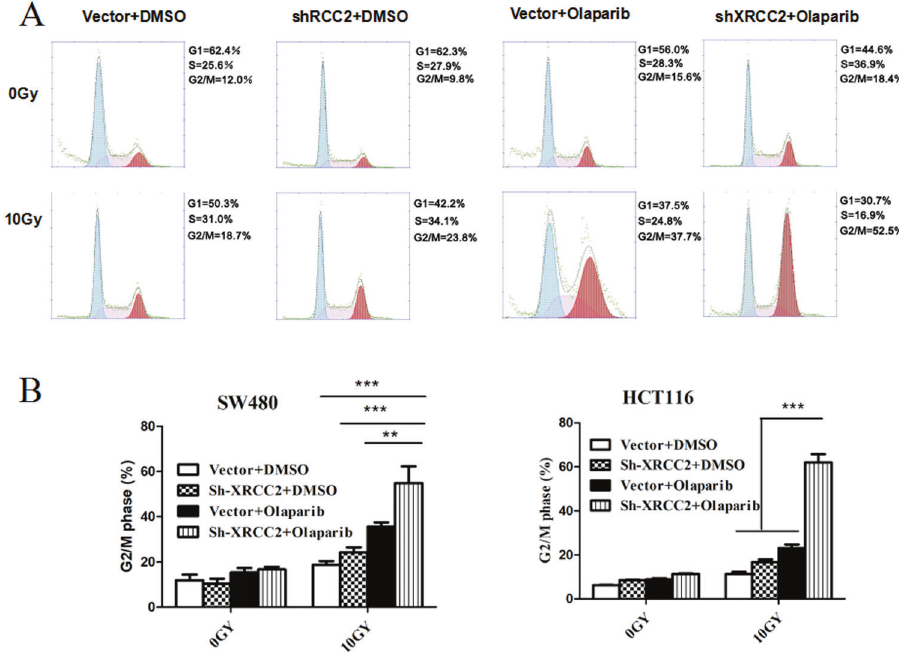
Fig. 4 Effect of olaparib on sensitization of XRCC2 -de fi cient cancer cells to IR-induced phase G2/M arrest. A Cell cycle pro fi les of cells with (sh-XRCC2) and without (vector) XCRCC2 knockdown at 48 h after the indicated treatment. B Quanti fi cation of fl ow cytometry results in the different treatment groups. Results show the means ± SDs from three independent experiments. ** P < 0.01, *** P < 0.001.